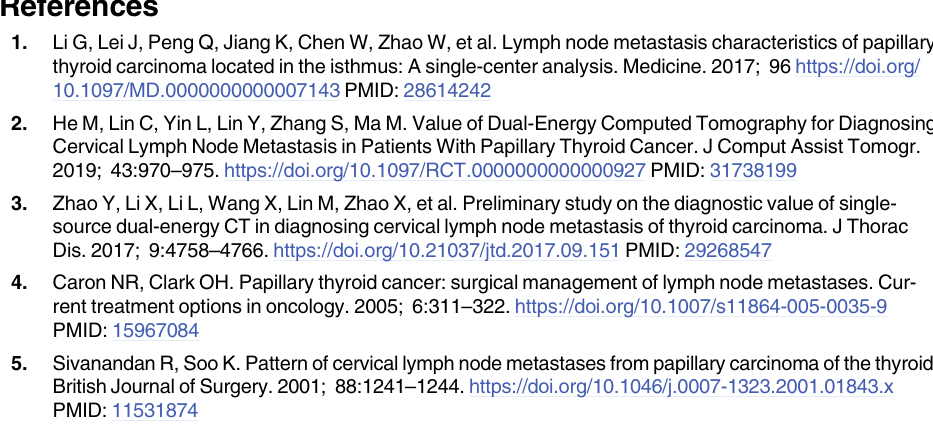
S1 Fig. Representative CT images of a 34-year-old female patient with a metastatic cervical lymph node in right cervical level IV. Three circular regions of interests were drawn from upper (a), middle (b), and lower (c) slices. (TIFF) S2 Fig. Two spectral HU curves of a benign (left) and metastatic (right) LN. (TIF) S1 Table. Comparison of DECT-derived parameters between the two methods of ROI mea- surements. S2 Table. Intraclass correlation coefficients of DECT-derived parameters acquired by two methods of ROI